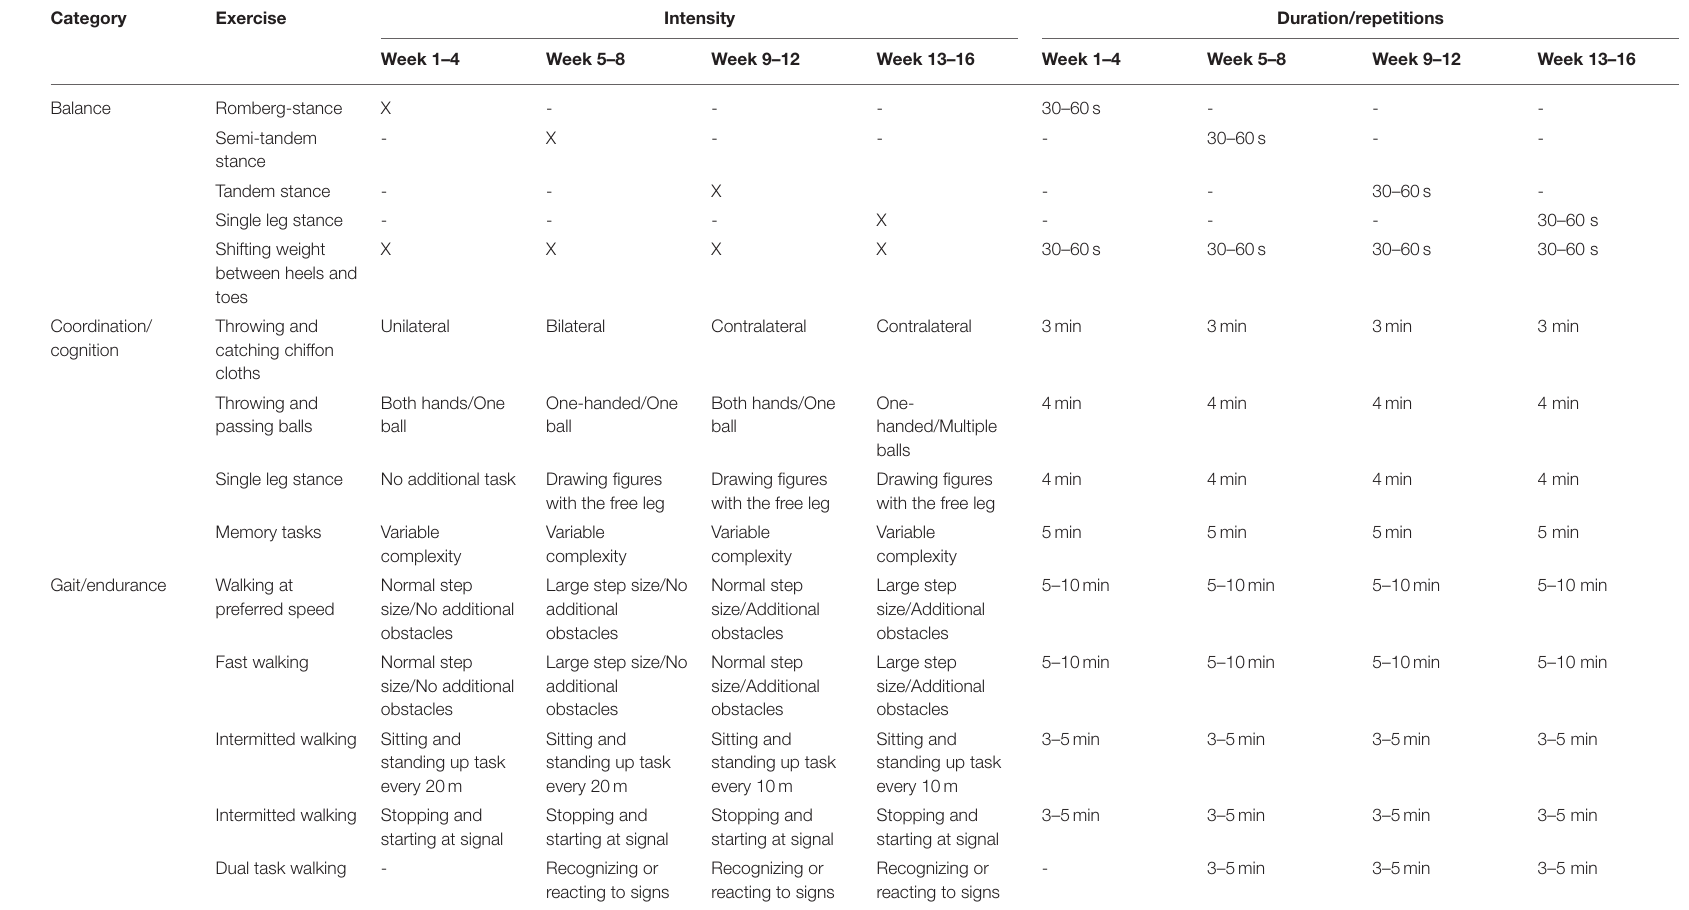
TABLE 1 | Intervention